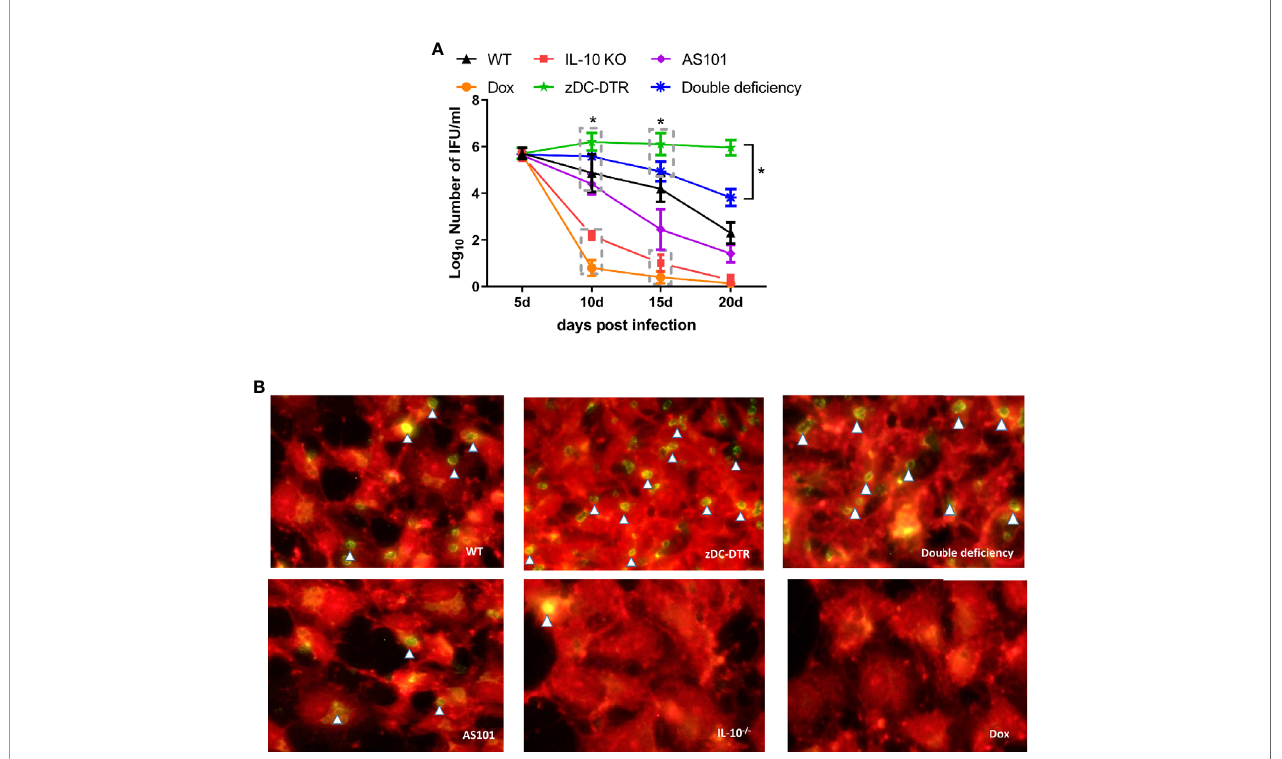
FIGURE 3 | Lung loads post Chlamydia infection. (A) Calculations of C. psittaci loads at 5, 10, 15, and 20 dpi using direct immuno fl uorescence. Data were expressed as the mean ± SD (n=8 mice per group). Lower bacterial loads were found in the Dox and IL-10 − / − groups compared with those of the zDC-DTR, DD, WT, and AS101 groups from day 10 to day 15. Afterward, high bacterial clearances were observed in the AS101 and IL-10 − / − groups. The IFUs of DD mice were signi fi cantly reduced compared with those of zDC-DTR mice at 20 dpi. (B) Direct immuno fl uorescence staining of Chlamydia inclusion bodies at 20 dpi. The green dots (white arrow) showed Chlamydia inclusion bodies. Differences were analyzed by ANOVA (* P